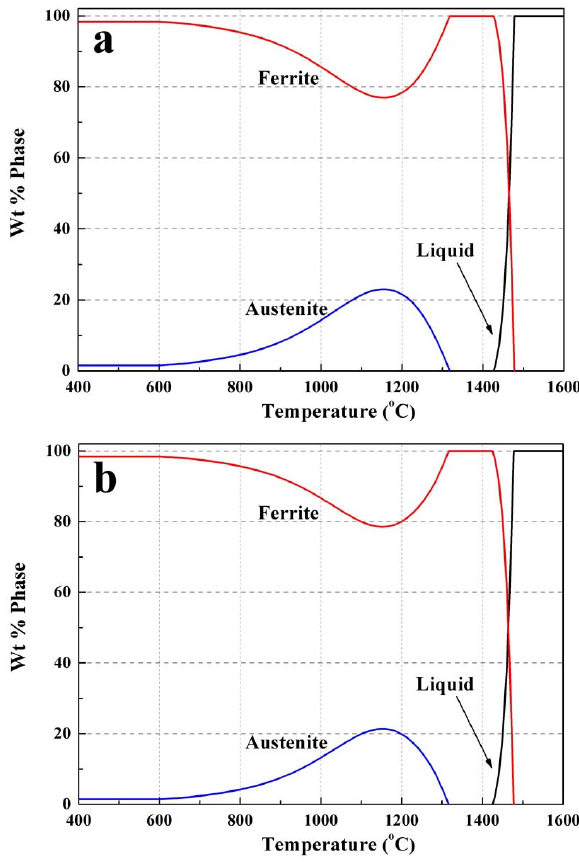
Figure 8: Precipitates content varies with the temperature (a) 0.028% Nb, (b) 0.052% Nb